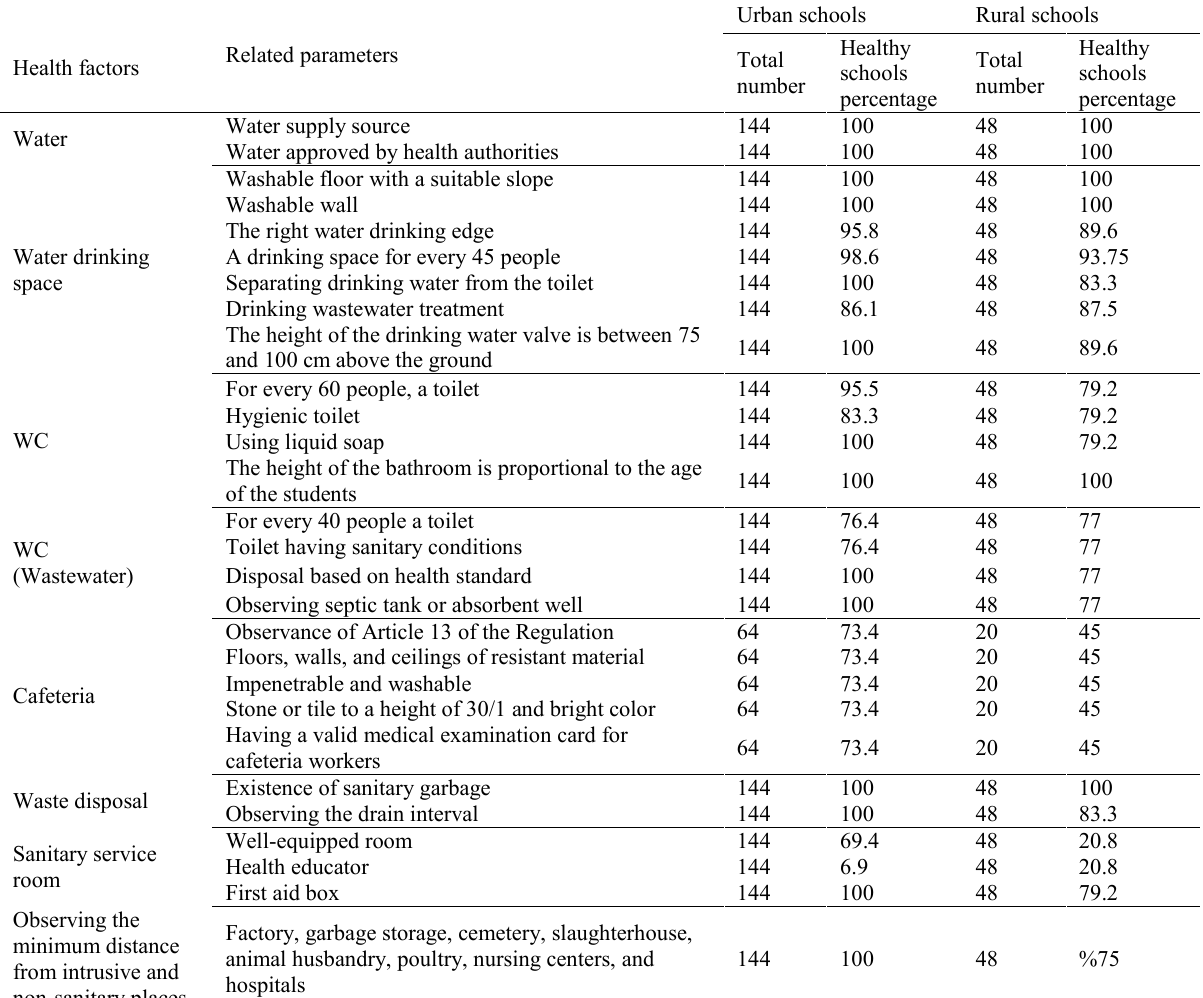
Table 1. Results of health status of schools in Abadan, by health